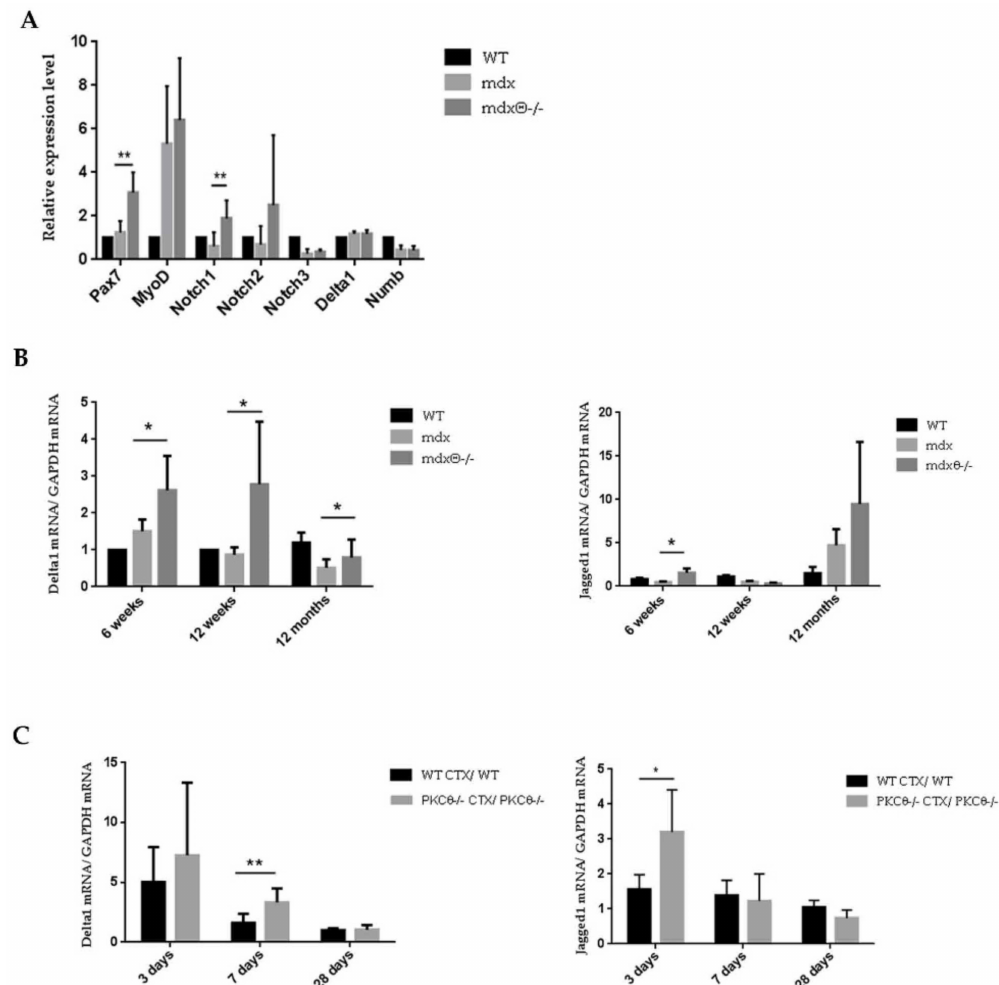
Figure 5. ( A ) Sorted SCs were analyzed for the level of expression of Pax7, MyoD, Notch receptors, Delta1, and Numb by qRT-PCR. RNA expression level in mdx and mdx θ − / − SCs was normalized against GAPDH. Samples represent three pooled RNA from SCs sorted from three mice for each sample. (* p < 0.05, ** p < 0.01, two-tailed Student’s t -test). ( B ) Delta1 and Jagged1 mRNA level in mdx and mdx θ − / − TA ( n = 4–7 / genotype / age). (* p < 0.05, two-tailed Student’s t -test). ( C ) Ratio of Delta1 and Jagged1 mRNA level between injured and contralateral uninjured TA muscle in WT / bl6 and PKC θ − / − at 3, 7 and 28 days after CTX injury ( n = 4–6 /